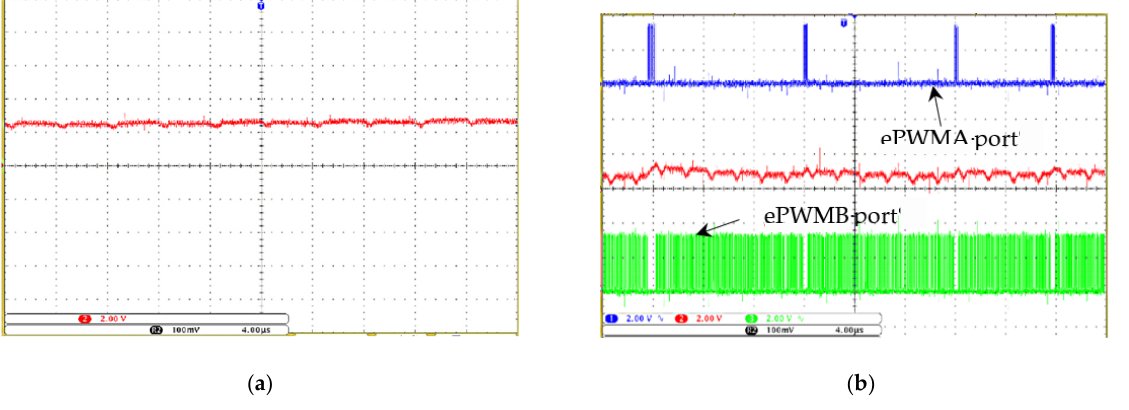
Figure 16. Waveforms of neutral-point potential control: ( a ) before control, ( b ) after control.